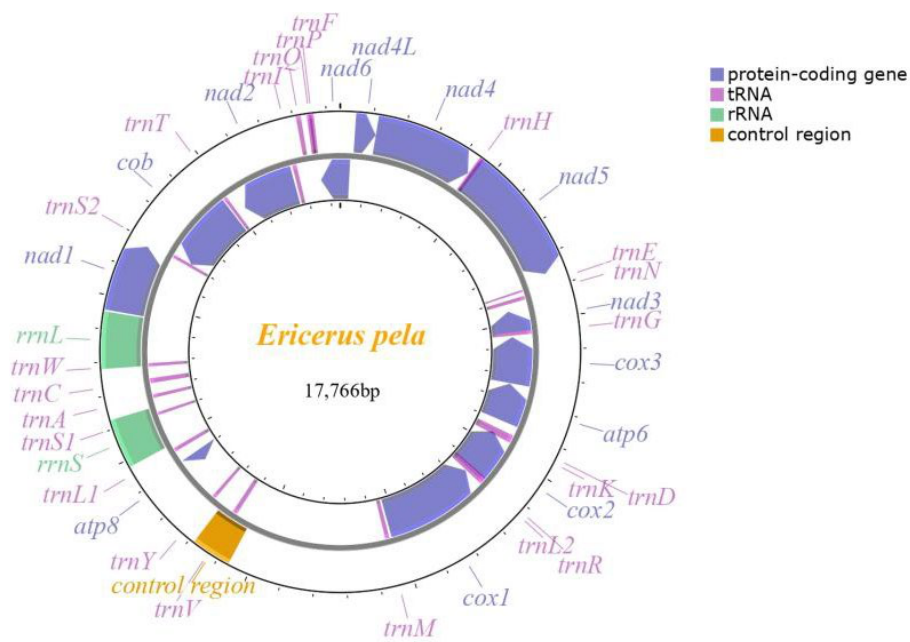
Figure 1. Mitochondrial gene map of E. pela . The 13 annotated PCGs included the three cytochrome c oxidase ( cox ) genes cox1 , cox2 , and cox3, one cytochrome b reductase gene cob, two ATP synthase synthesis genes atp6 and atp8, and seven NADH dehydrogenase genes nad1 , nad2 , nad3 , nad4 , nad4L , nad5 , and nad6 . In addition to the 13 PCGs, there were 24 essential genes without coding protein in the mitochondrial genome, which included 22 transfer RNA genes and two ribosomal RNA genes ( rrnL and rrnS ). Specifically, only 13 tRNA genes were identified and depicted by either the MITOS webserver or the tRNAscan-SE search server (Table